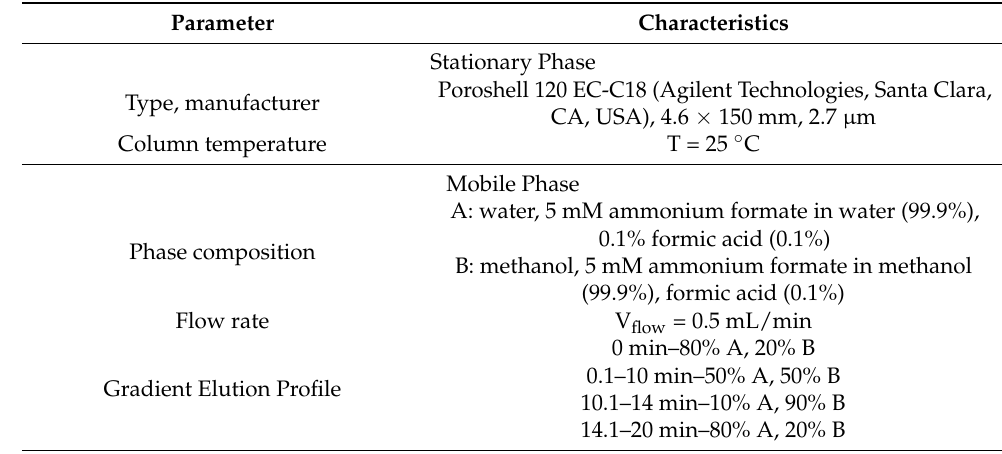
Table 1. Characteristics of parameters for the determination of tannin compounds by means of the HPLC-DAD-MS